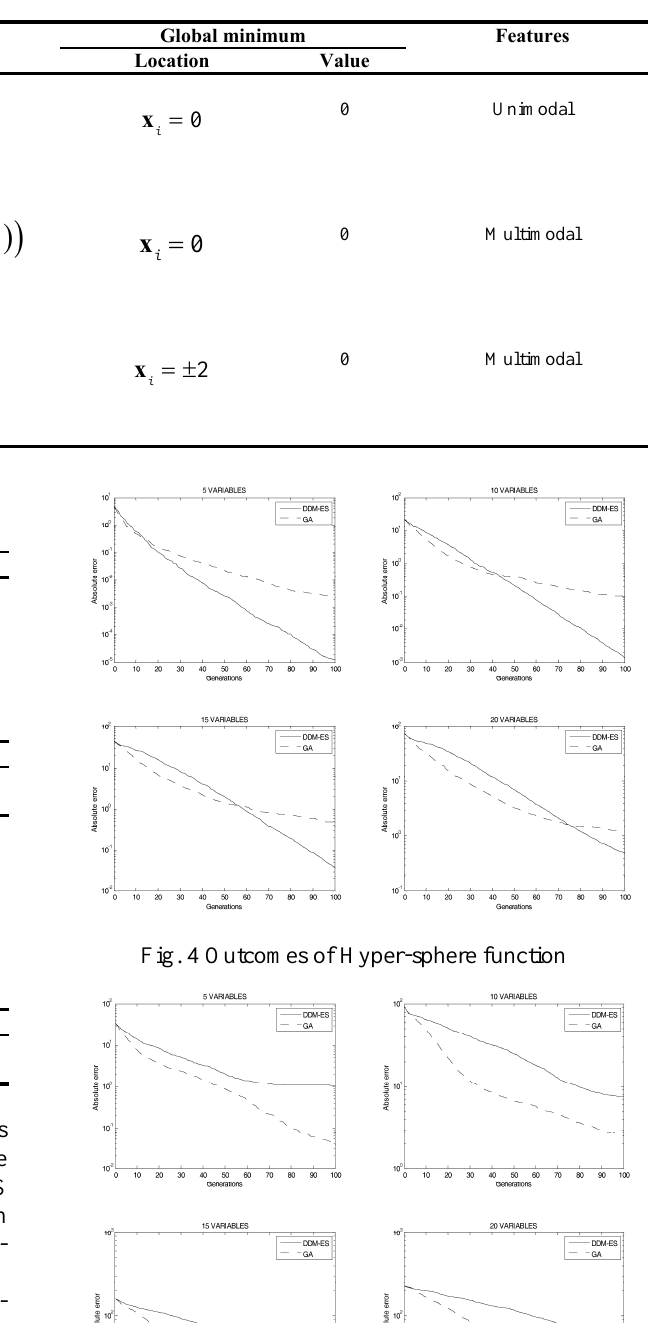
Table 4. Test functions